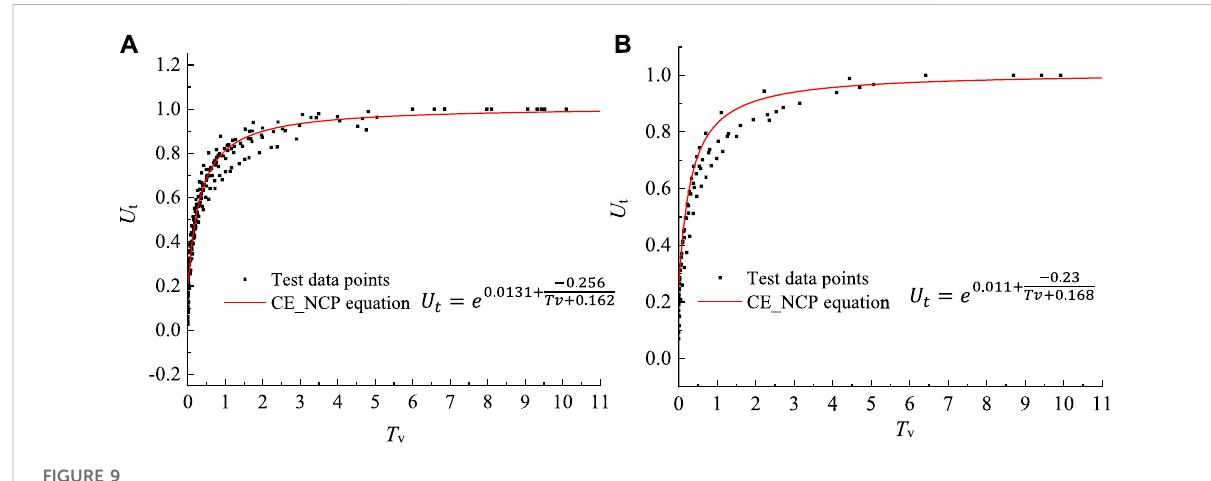
FIGURE 9 Applicability veri fi cation of CE_NCP equation, when the load is 5.12 MPa with depth of 100 – 200 m (A) and the load is 5.12 MPa with depth of 200 – 300 m (B)